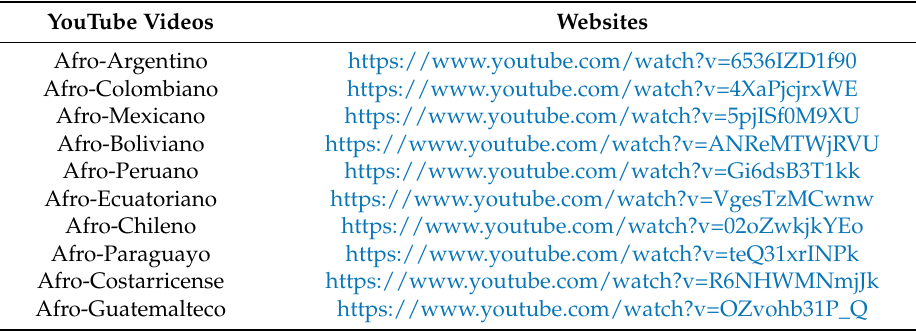
Table 1. YouTube Videos of Afro-Hispanics in the